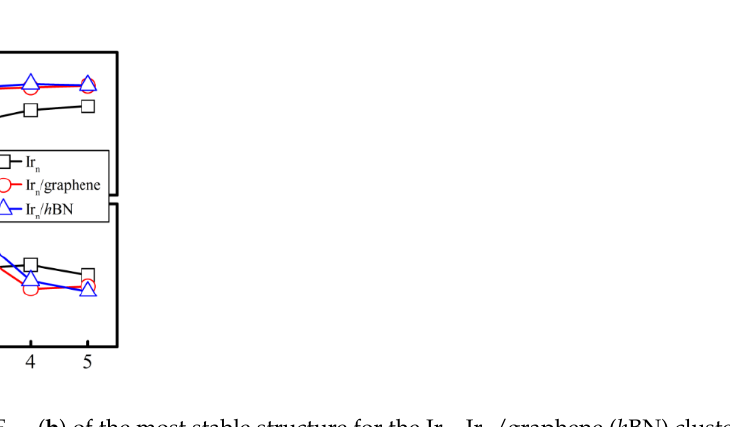
Figure 4. E coh ( a ) and E def ( b ) of the most stable structure for the Ir n , Ir n /graphene ( h BN) clusters (n =